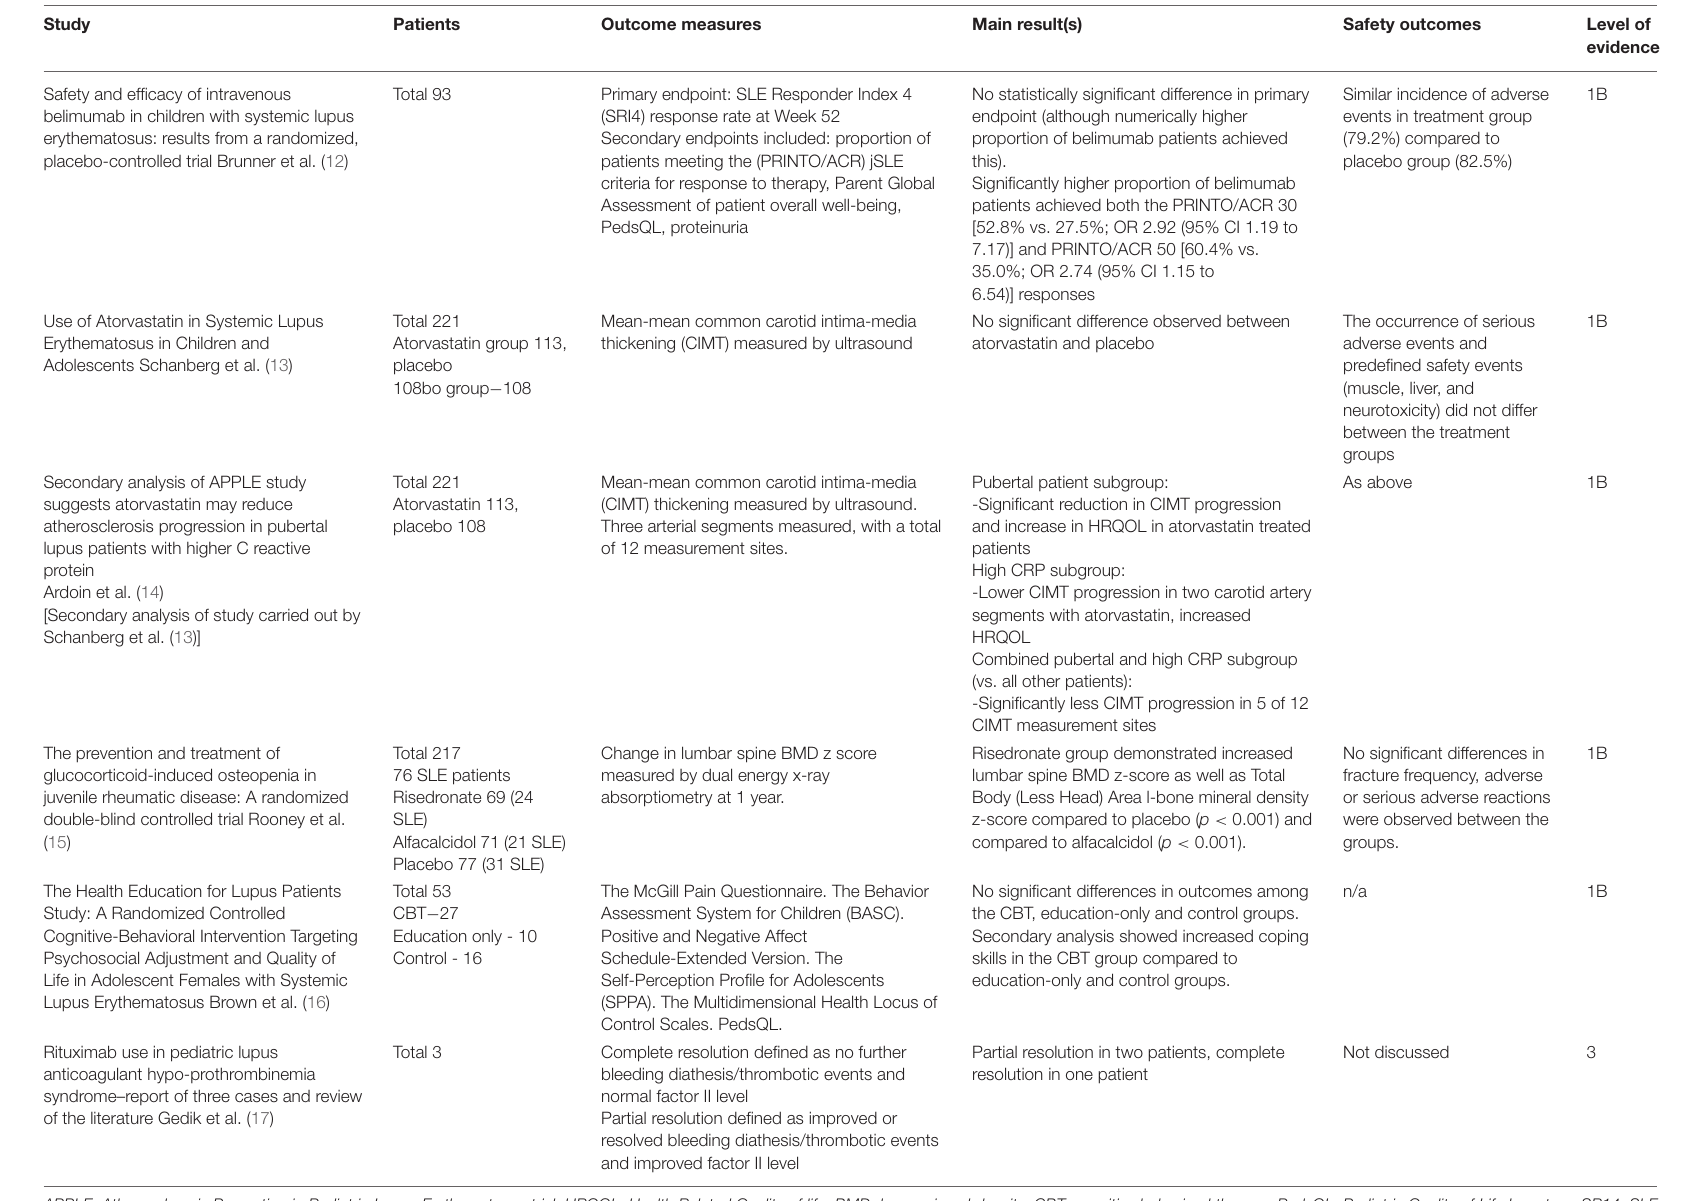
TABLE 1 | Summary of pediatric lupus treatment studies from